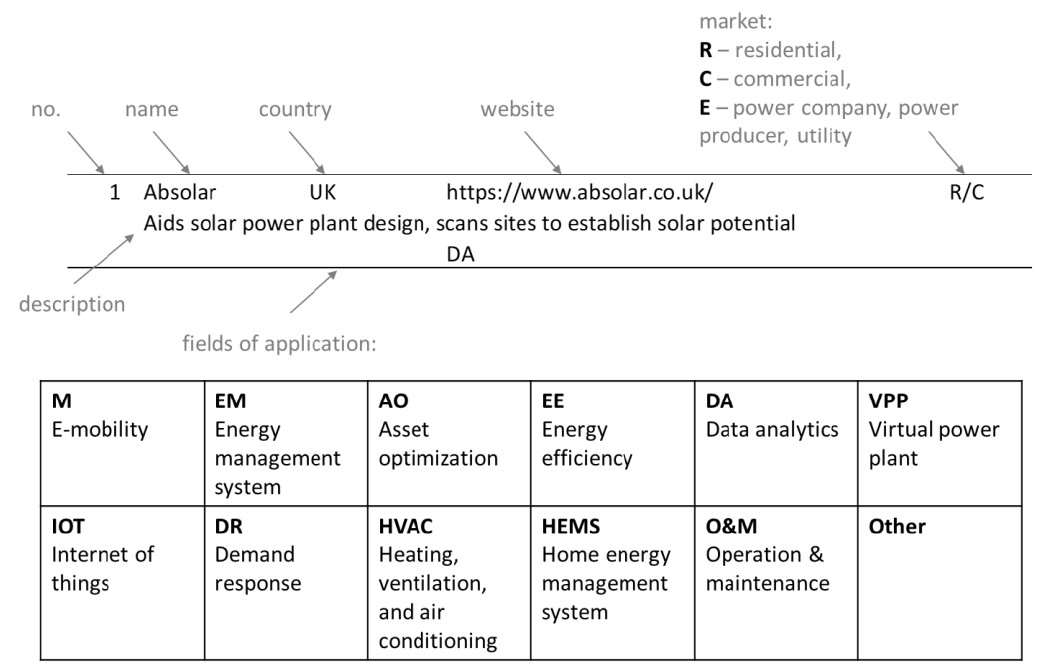
Figure A1. Explanation of Table A1. Table A1. 220 AI companies in the power sector in 2022. (websites last accessed on 5 th on January 2023)